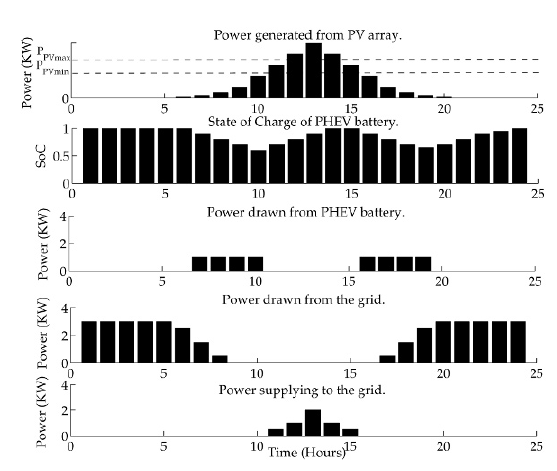
Figure 6. Pattern of daily operation of the proposed